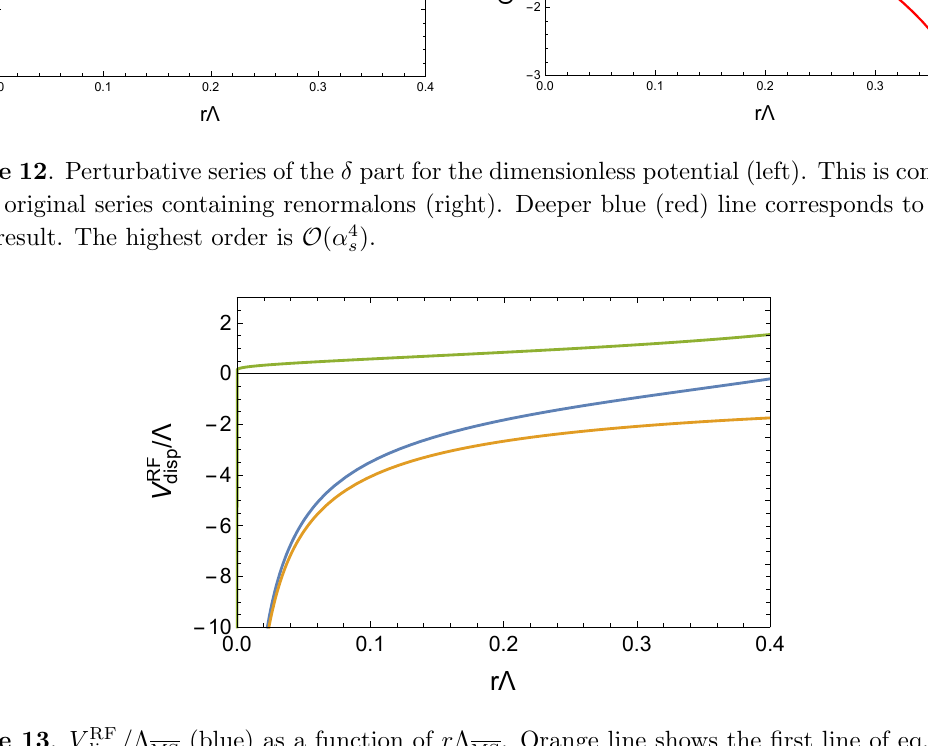
Figure 13 . V RF = (cid:3) (blue) as a function of r (cid:3) disp MS and green line does the second line of eq.